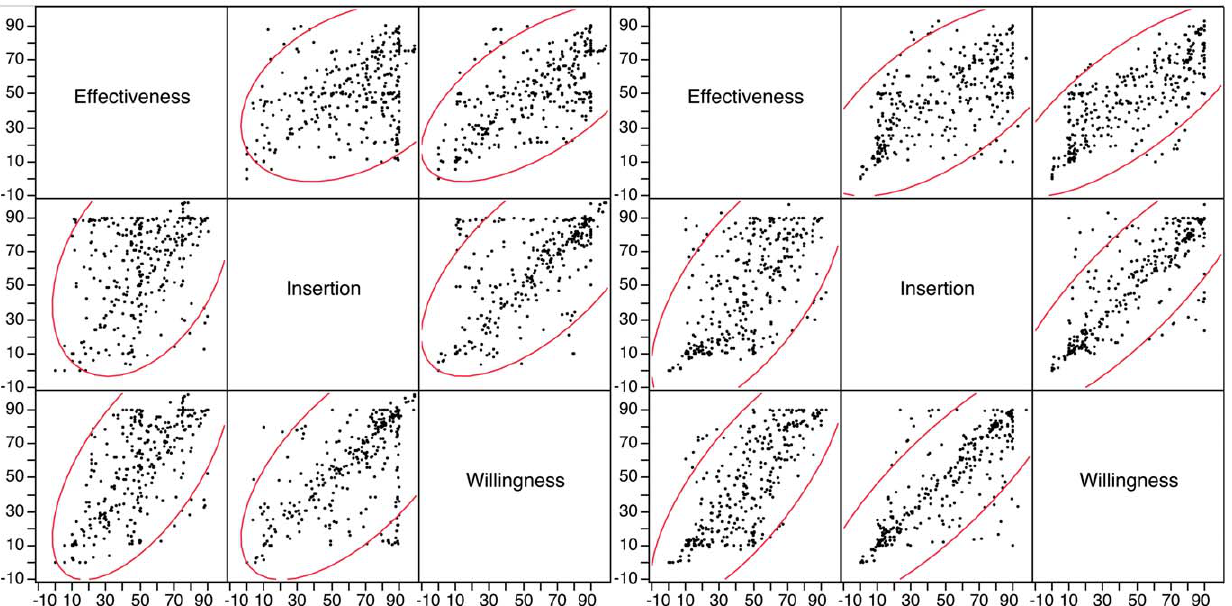
Figure 5. Correlations between effectiveness , insertion and willingness in the with-applicator (left) and without-applicator groups (right).